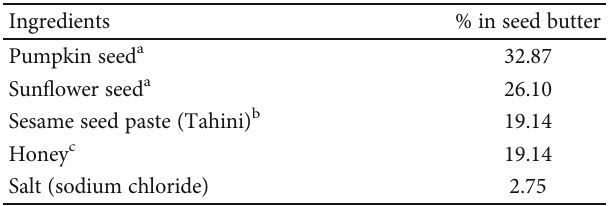
Table 1: Ingredients and formulation.